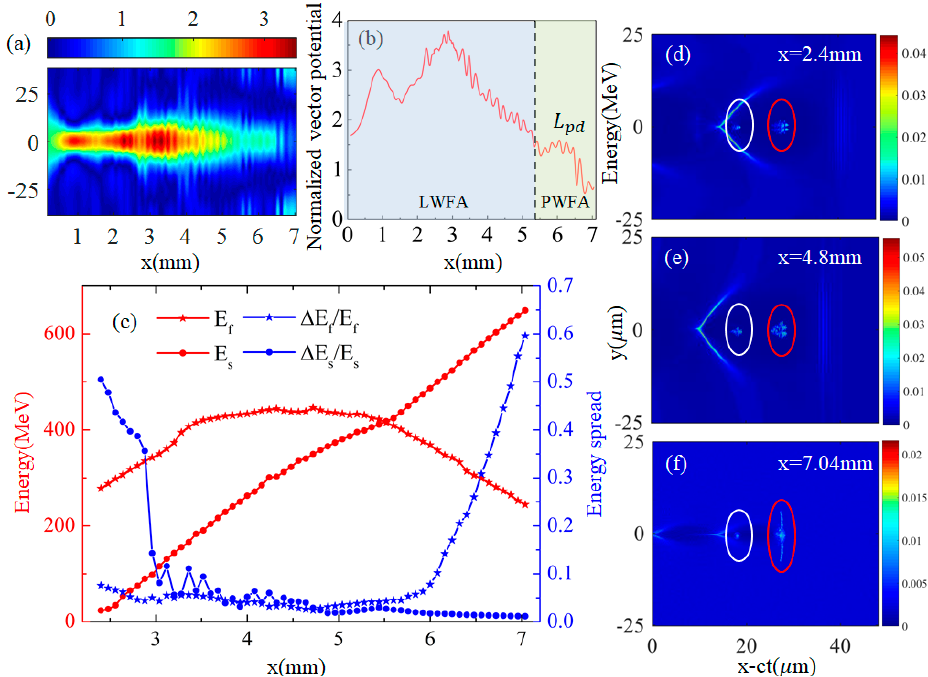
Figure 3. ( a ) Evolution of the transverse beam intensity along the laser propagation. ( b ) Evolution of the on-axis normalized vector potential. The dark dotted line represents the distance of laser pump depletion. ( c ) Evolution of the e -beams’ peak energy and FWHM energy spread. The red line represents the energy and the blue line represents the FWHM energy spread. The star corresponds to the first e beam and the dot corresponds to the second e -beam. (d–f) Snapshots of the e -beams’ density distribution and wakefield structure for ( d ) x = 2.4 mm, ( e ) x = 4.8 mm, and ( f ) x = 7.04 mm.